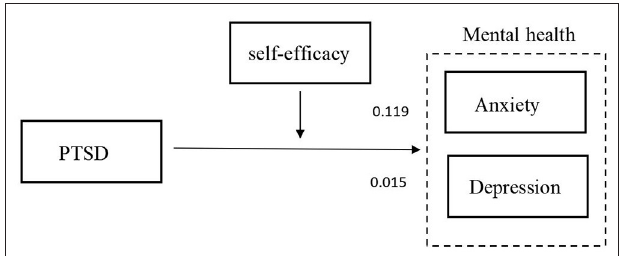
FIGURE 4 | Modified model and standardized path